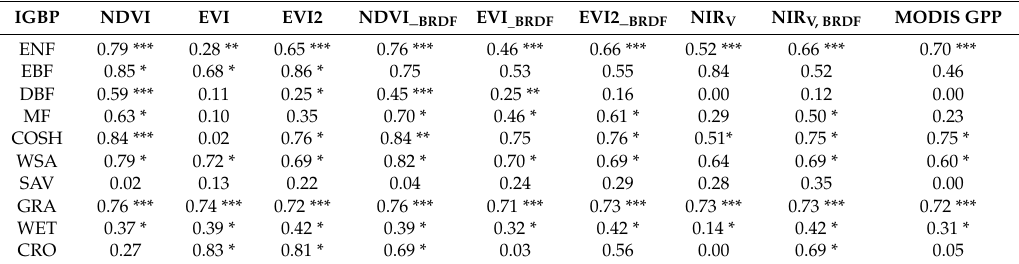
Table 1. The coefficient of determination (R 2 ) values for the relationships of the VIs and MODIS GPP with tower GPP at the annual scale across all sites within each biome in Figure 4. The asterisks - *, ** and *** stand for the significance level p < 0.05, p < 0.01 and p < 0.001, respectively.